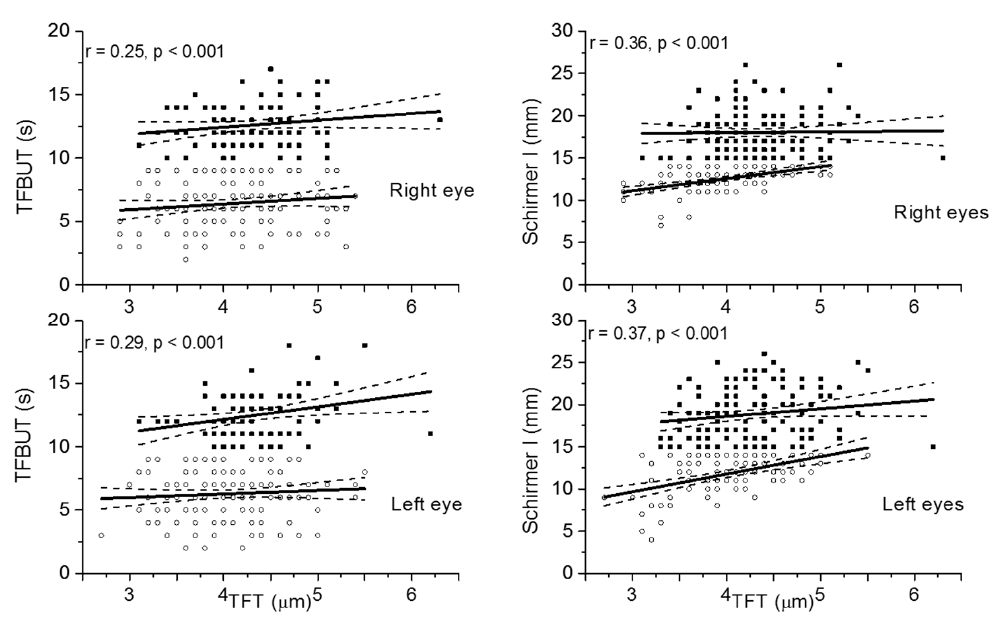
Figure 2. Correlation between Tear Film Thickness (TFT) and Tear Film Break Up Time (TFBUT) and Schirmer I test (Schirmer I). Correlations are presented for overall values, details can be found in Table 2). Data are separately presented for right and left eyes ( n = 225). The data representing normal TFBUT ( > 9 s) and normal Schirmer I ( > 14 mm) are presented in black squares. The data representing abnormal TFBUT and abnormal Schirmer I are presented in open circles. The regression line (solid line) and the 95% confidence interval are shown (dashed lines).